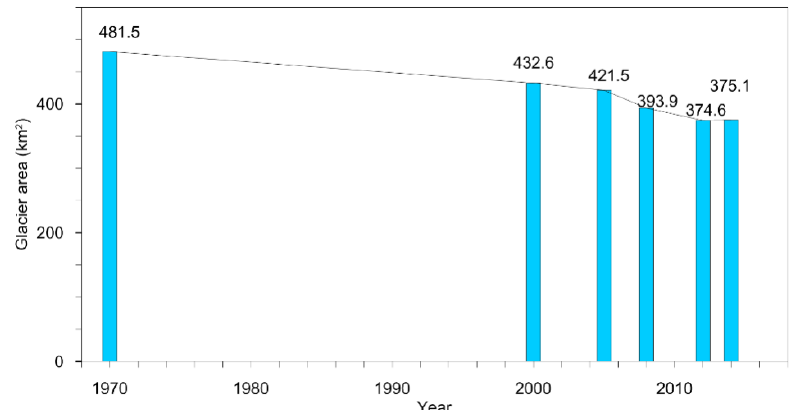
Figure 4. Variations in the glacier area in the Upper Reach of Shule River Basin from Chinese Glacier Inventory (CGI) (1970), 2000 to 2015.